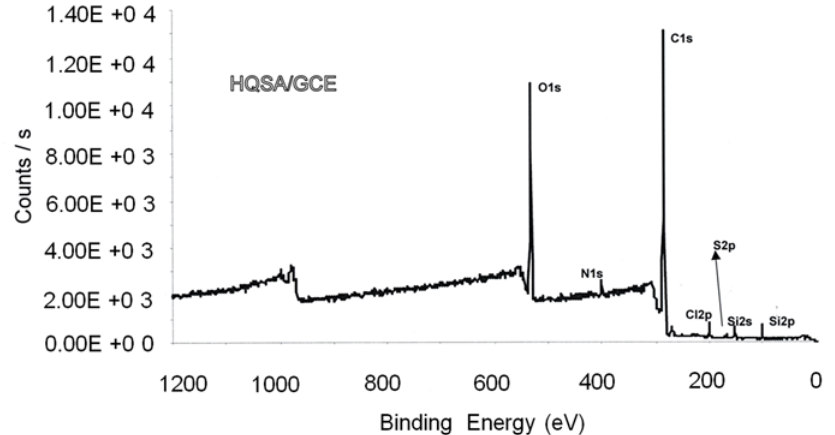
Figure 1. Survey scan relevant to a glassy carbon electrode surface-modified by